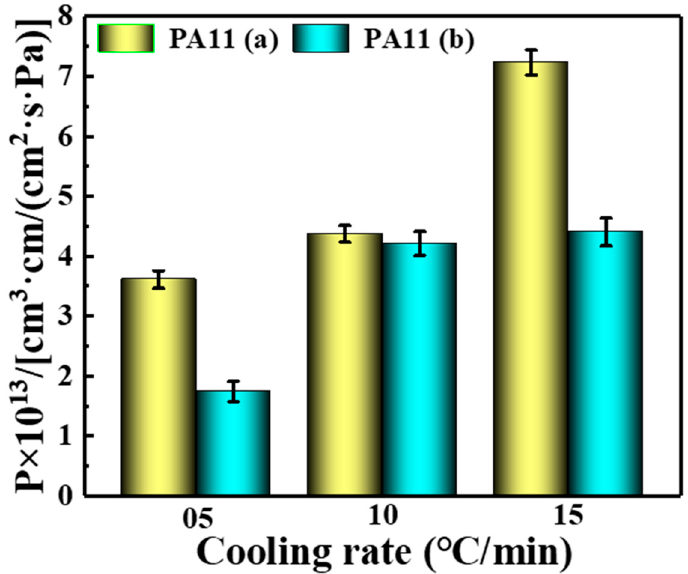
Figure 12. Gas permeability coefficient at different cooling rates.